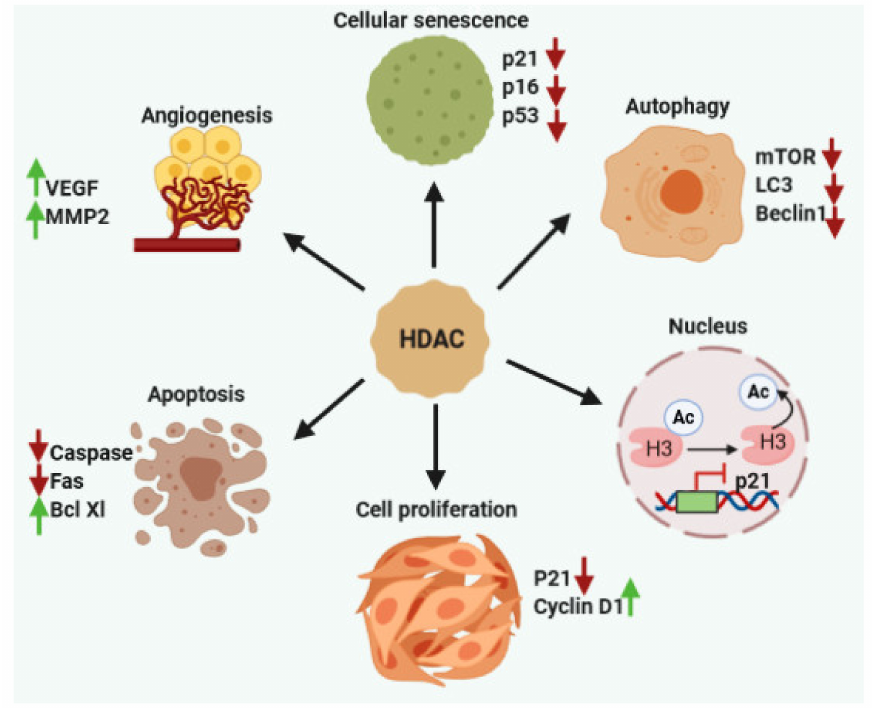
Figure 2. HDACs help in the progression of cancer cell growth and spreading via regulating cell proliferation, angiogenesis, apoptosis, metastasis, autophagy, and